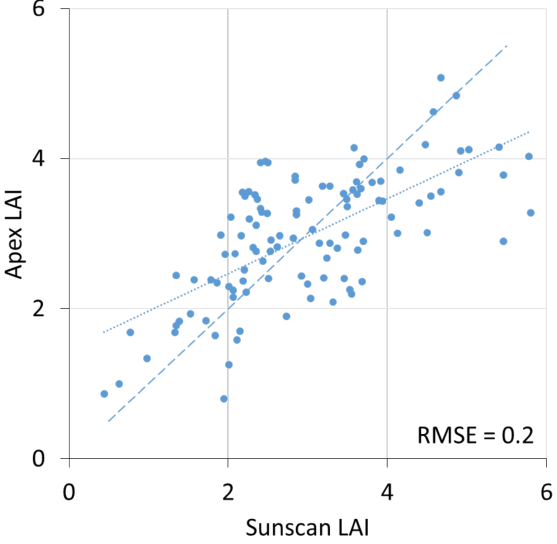
Figure 4. Scatter plot of measured LAI (x-axis) vs. APEX LAI (y-axis) for 106 trees. Linear regression as the dotted and 1:1 as the dashed